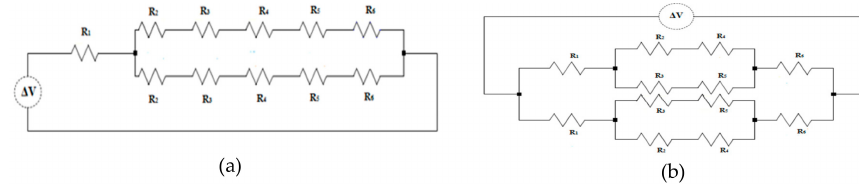
Figure 6. Scheme of the electrical circuits adopted in configurations 1, 2, 4 ( a ) and configuration 3 ( b